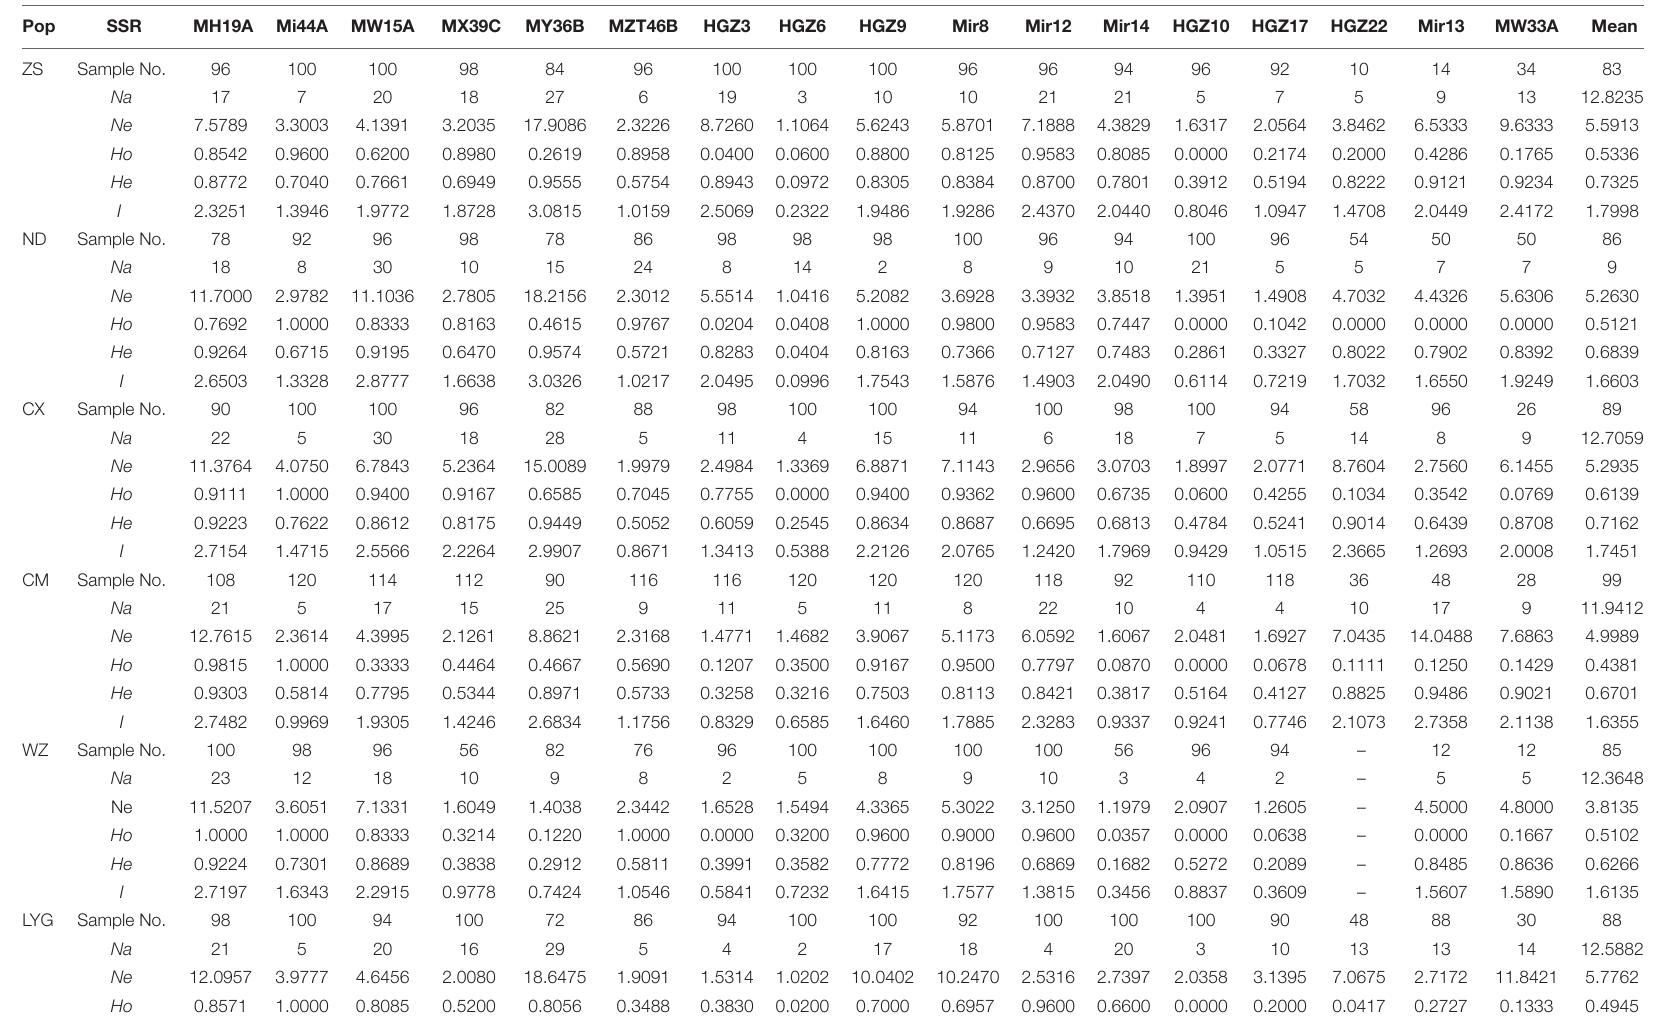
TABLE 3 | Genetic diversity of six populations of rainbow clams. Pop SSR ZS Sample No.